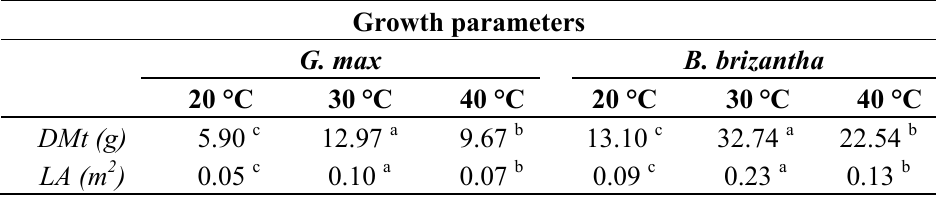
Table 3. Mean values of total dry mass ( DMt ) and leaf area ( LA ) in G. max and B. brizantha under different temperature conditions (°C).